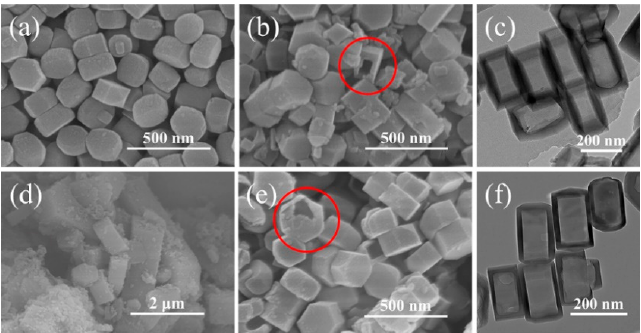
Figure 1. FE-SEM images of ( a ) S-1 ( b ) hS-1, ( d ) cZSM-5, ( e ) hZSM-5, and FE-TEM images of ( c ) hS-1 and ( f ) hZSM-5 zeolites.